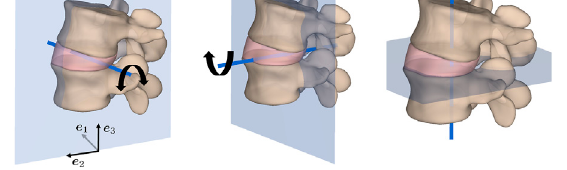
FIGURE 2 Load cases of (A) fl exion/extension in the sagittal plane, (B) lateral bending in the frontal plane, and (C) axial rotation in the transverse plane for an applied moment of 5 Nm about the illustrated axis of rotation through the geometric center of the